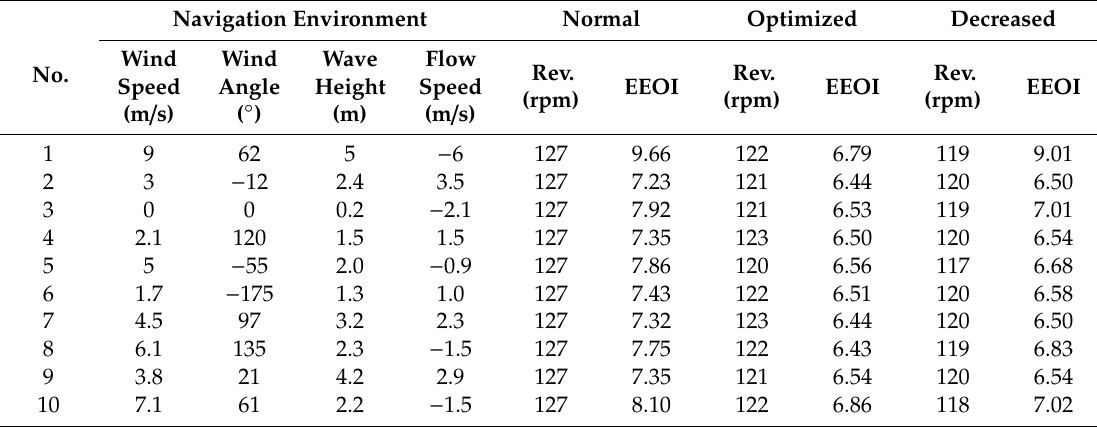
Table 4. Energy E ffi ciency Operational Indicator (EEOI) optimization